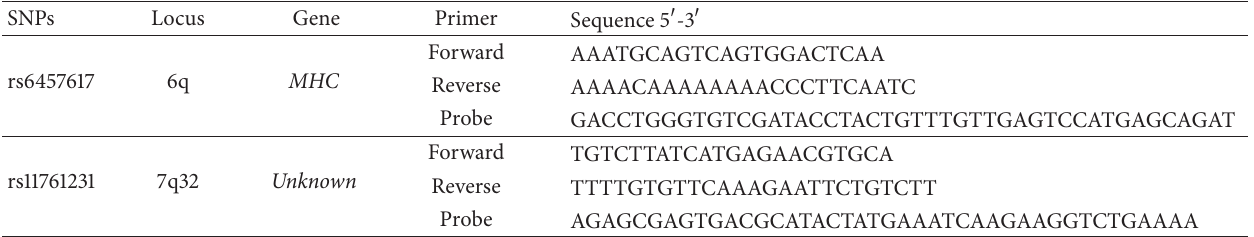
Table 1: PCR primers and tagged extension probes used for SNP detection.